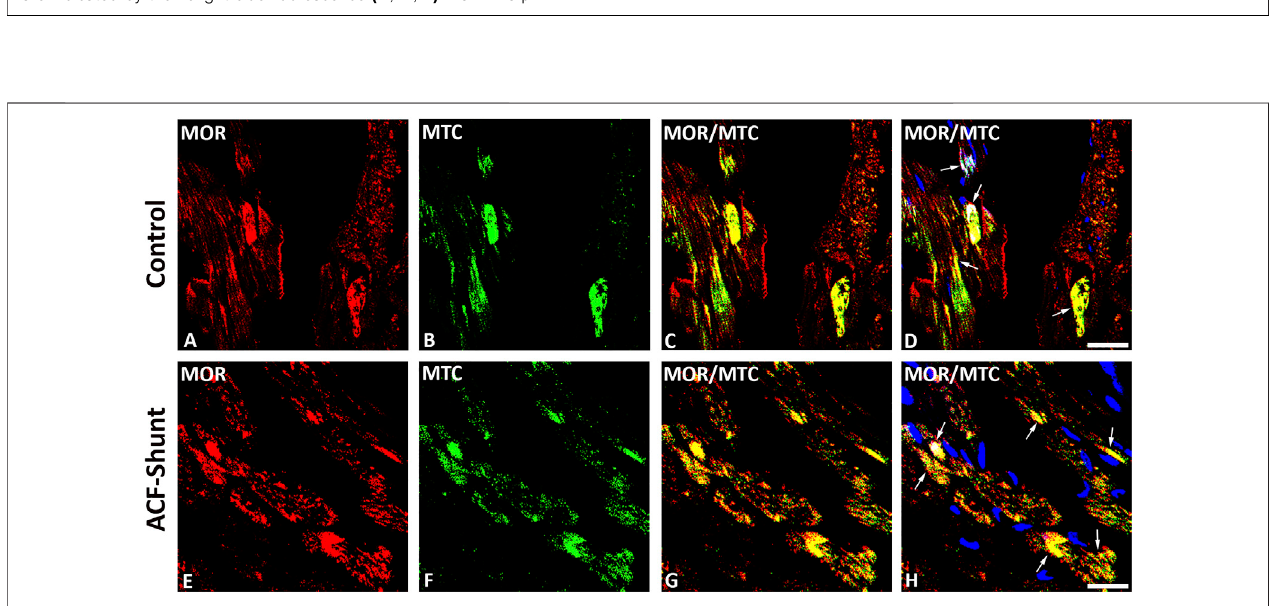
FIGURE3| Doubleimmuno fl uorescencestainingofmu-opioidreceptor(MOR) (A , E) (red fl uorescence)andmitochondrialmarkerMCT02(green fl uorescence) (B , F) inratleftventricularmyocardiumfromcontrols (A – D) andratswithACF-inducedvolumeoverload (E – H) . (A – D) showthatsomeofMORimmunoreactivitycolocalized intracellularly with well-de fi ned mitochondrial structures (mitochondrial marker MCT02) (colocalization seen as yellow immuno fl uorescence) (arrow). (E – H) show MOR colocalized with swollen mitochondrial structures (mitochondrial marker MTC02) of rat LV cardiomyocytes. (Bar = 10 µm).